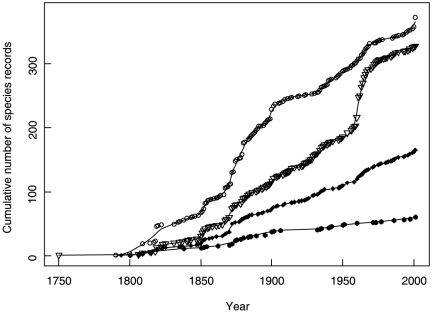
Temporal patterns of introduction of alien neophytes into the Czech Republic with particular pathways.Fitted curves are LOESS best regression models on square root numbers of cumulative records (back-transformed for visualization) with no patterns of residuals, chosen by deletion test against starting models with small spans (<0.1). Release (black circles): span of smoothing = 0.4; equivalent number of parameters in curvilinear regression ENP = 8.2; explained variance r2 = 0.99; deletion test against the best polynomial model F = 7.75; df = 1.91; P<0.01. Escape (open circles): span = 0.11; ENP = 27.8; r2>0.99; deletion test F = 71.34; df = 1.65; P<0.001. Contaminant (open triangles): span = 0.10; ENP = 31.8; r2>0.99; deletion test F = 36.36; df = 5.10; P<0.001. Stowaway (black diamonds): span = 0.10; ENP = 34.0; r2>0.99; deletion test F = 45.50; df = 1.57; P<0.001.